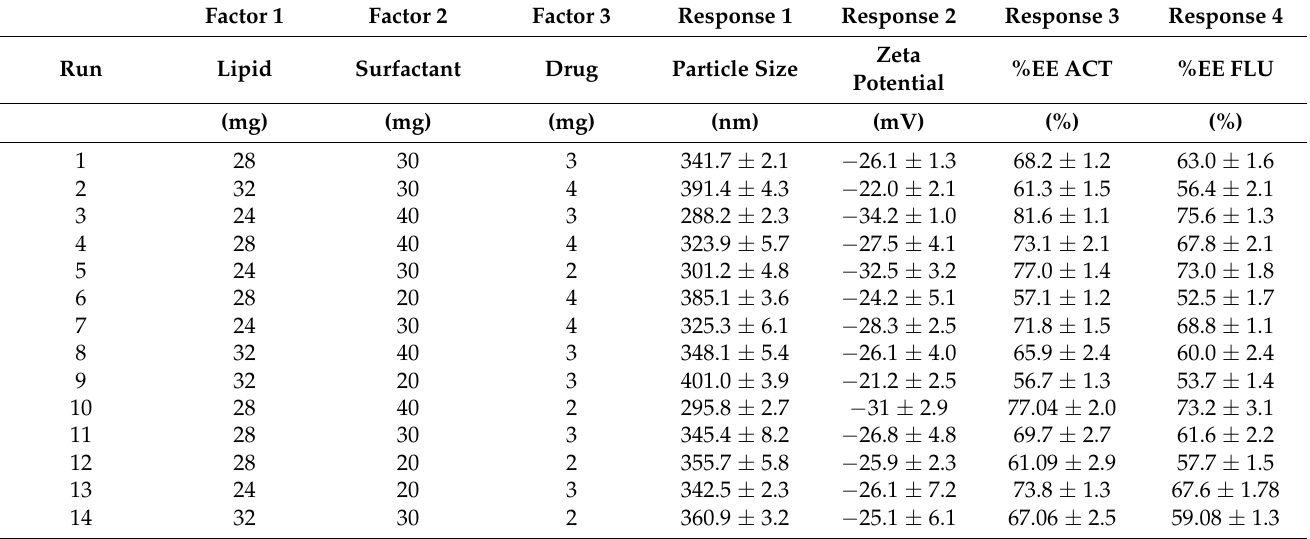
Table 1. Optimization of FLU–ACT–coloaded NLCs.